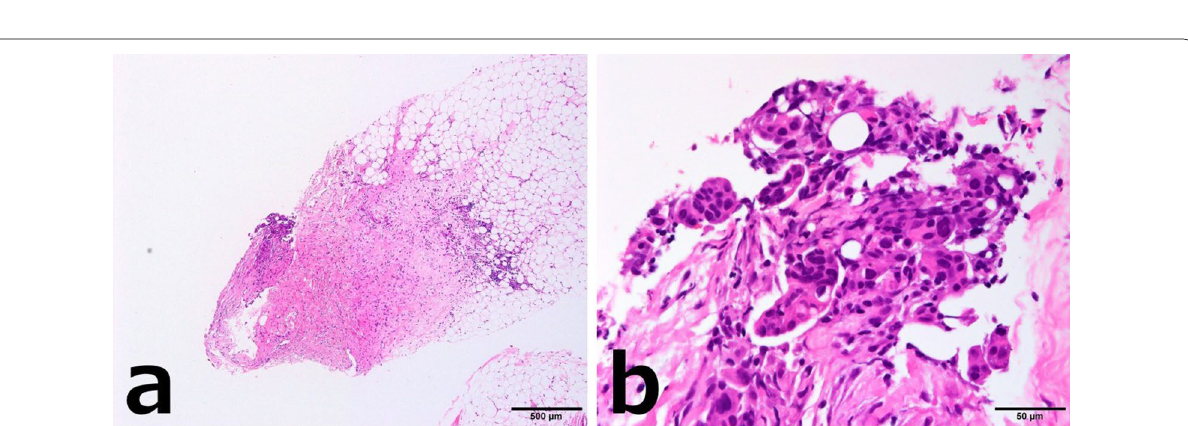
Fig. 6 Case 2: breast tumor histopathology (hematoxylin/eosin staining). a